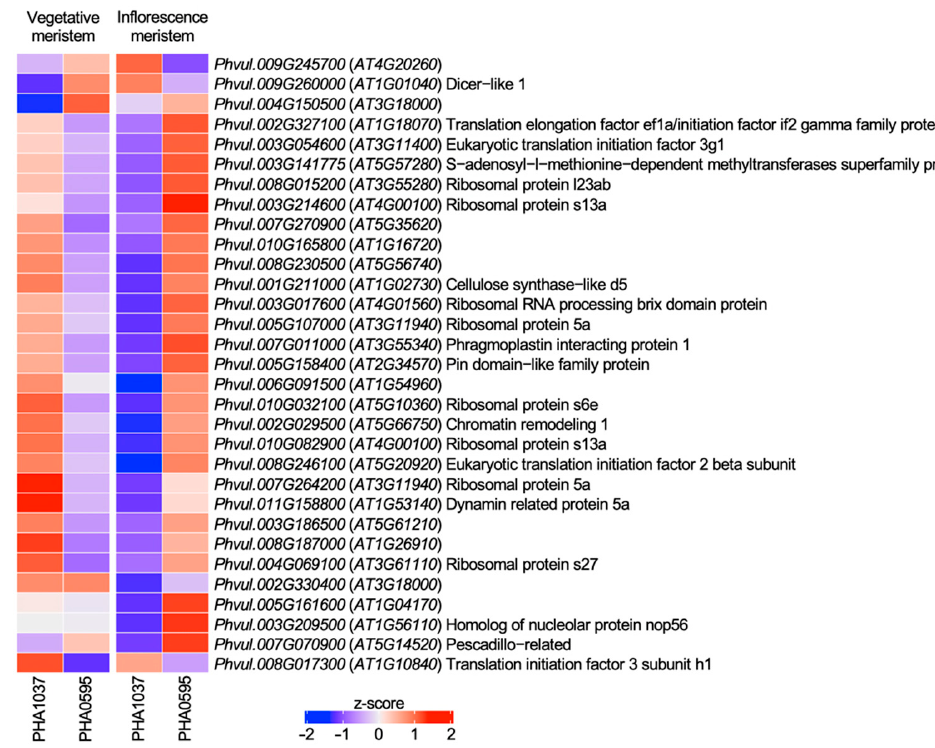
Figure 4. Transcription levels of discordant genes annotated with enriched GO terms showing opposite expression patterns in PHA1037 and PHA0595. For each gene, its expression levels have been represented as z-score using a color scale from blue (lowest level) to red (highest level). In each case, the identifiers of the common bean gene and its homologous gene in Arabidopsis are indicated (in brackets), as well as a description of the latter (when available). Details on these genes are given in Table S8.